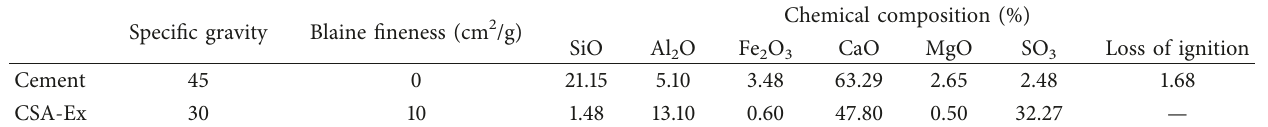
Table 2: Chemical components of cement and expansive